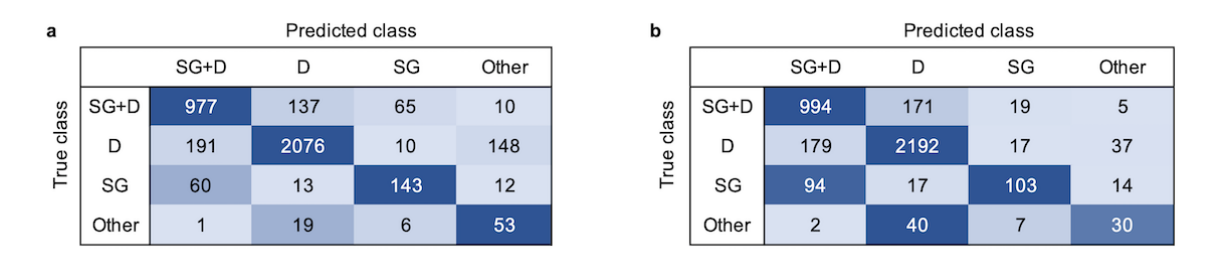
Figure 4. (a) Classifier and (b) human coder confusion matrices for overall performance. D: Dialogue; SG: Screen Gaze; SG+D: Screen Gaze +